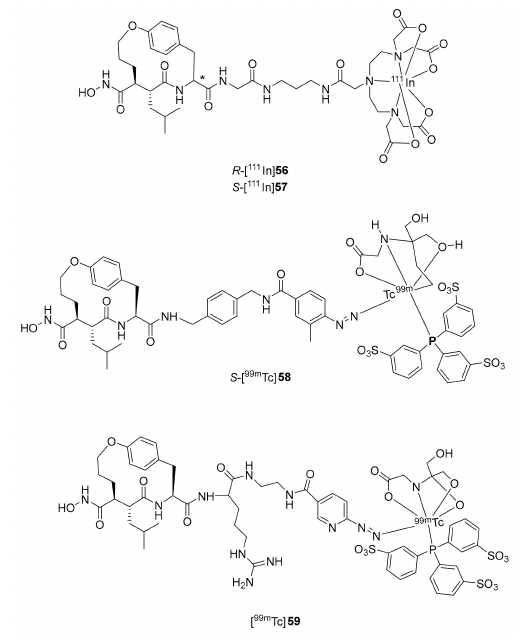
Scheme 13. Chemical structure for compounds 56 – 59 .